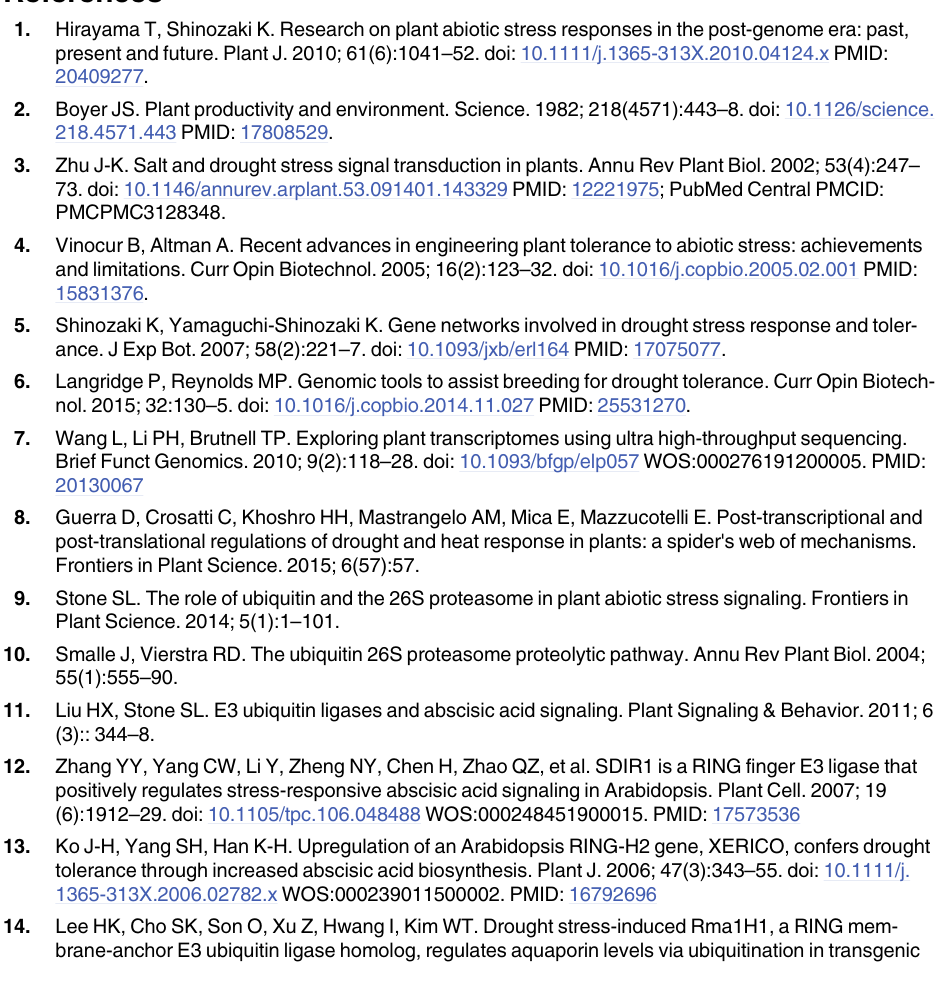
S1 Table. Primers for PCR, cloning, and construction of vectors. S2 Table. Specific primers sequences for RT-PCR of Grimmia pilifera . S3 Table. Specific primers sequences for qRT-PCR expression analysis of drought stress- related genes in Arabidopsis . S4 Table. Summary on screening results of forward library ESTs cloned by